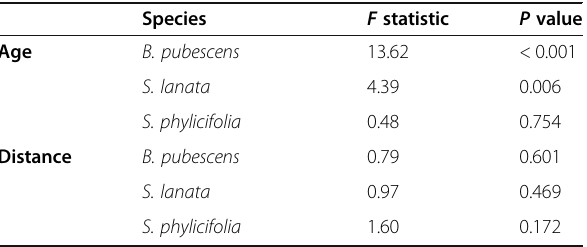
Table 2 One-way ANOVA results analyzing variance in specimen density data of B. pubescens , S. lanata , and S. phylicifolia grouped by age of the moraines and by distance from Skaftafelsheiði, respectively Species F statistic P value Age